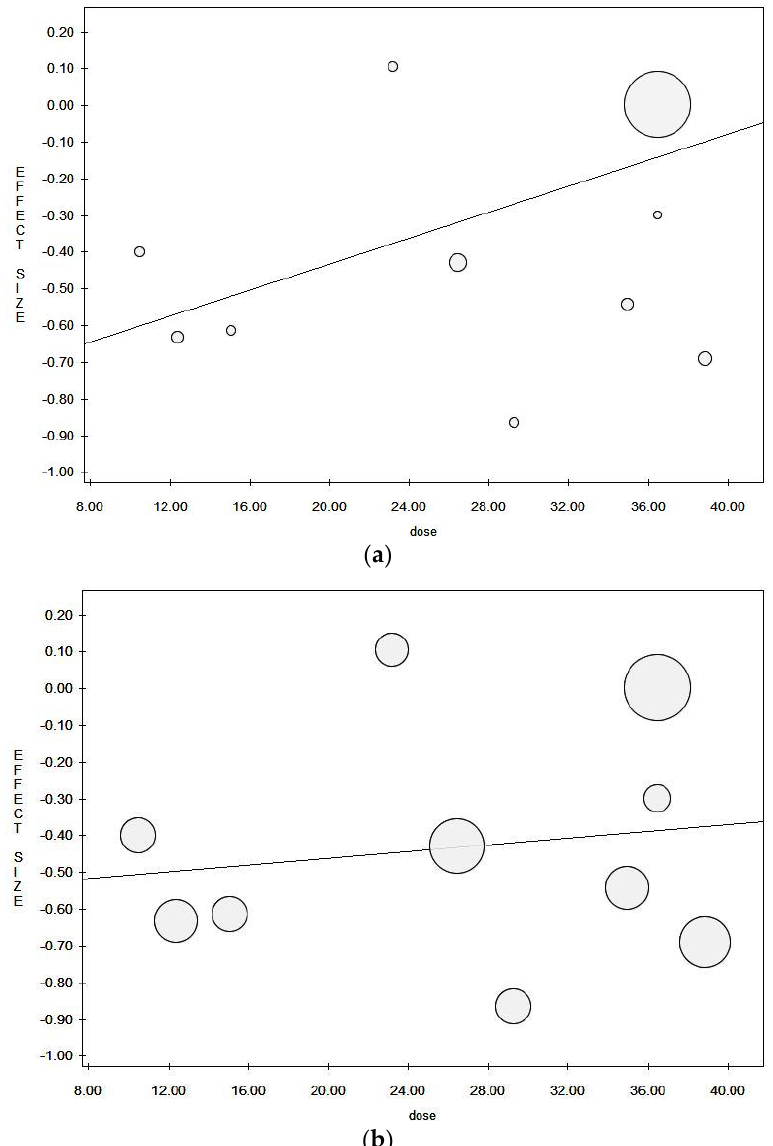
Figure 3. Meta-regression plot for ( a ) the fixed effect model and ( b ) the random effect model. Table 3. Results of the sensitivity and subgroup analyses.